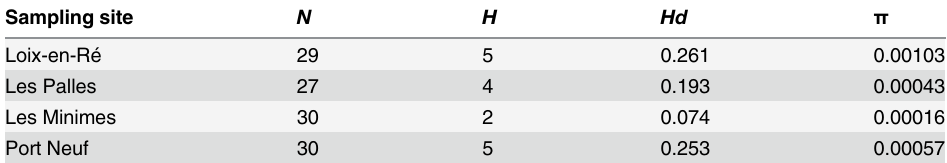
Table 4. Genetic diversity indices for Mimachlamys varia (four sampling sites) calculated using sequences spanning 477 bp of the mitochondrial cox1 gene. N : number of sequences analyzed; H : num- ber of haplotypes; Hd : haplotype diversity; π : nucleotide